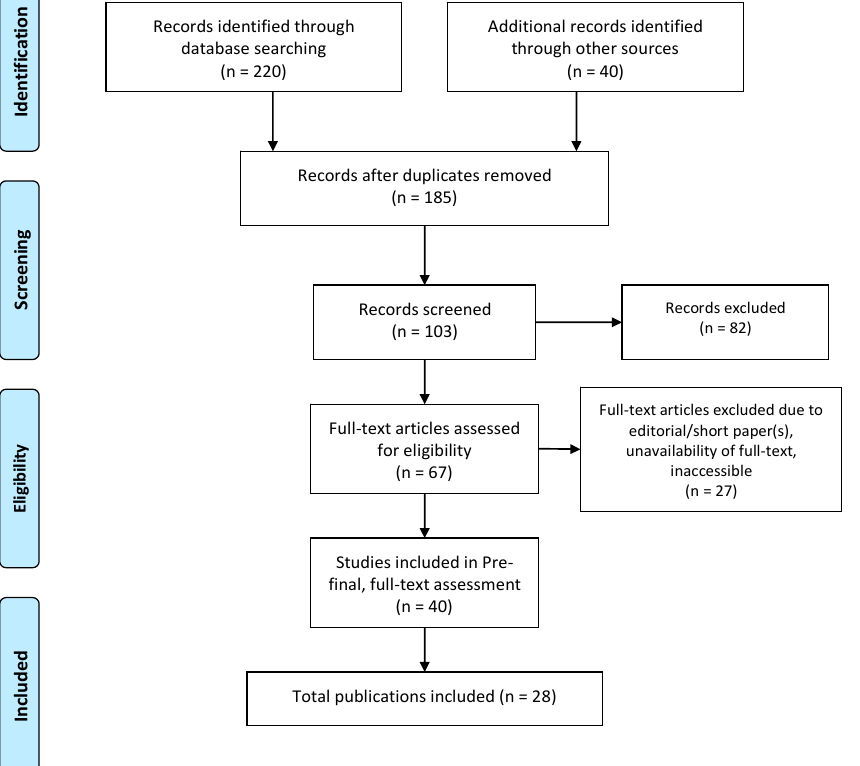
Figure 1. Prisma flowchart for the article selection process [16]. Table 1. Epidemiological study design [16].